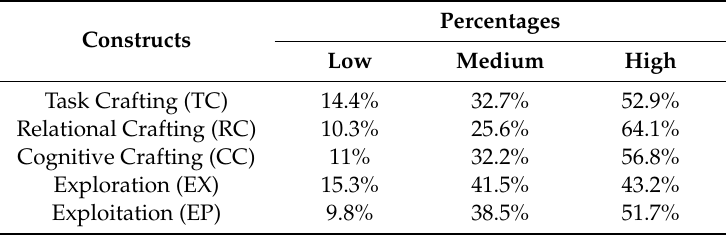
Table 3. The percentage level of ambidextrous and job crafting